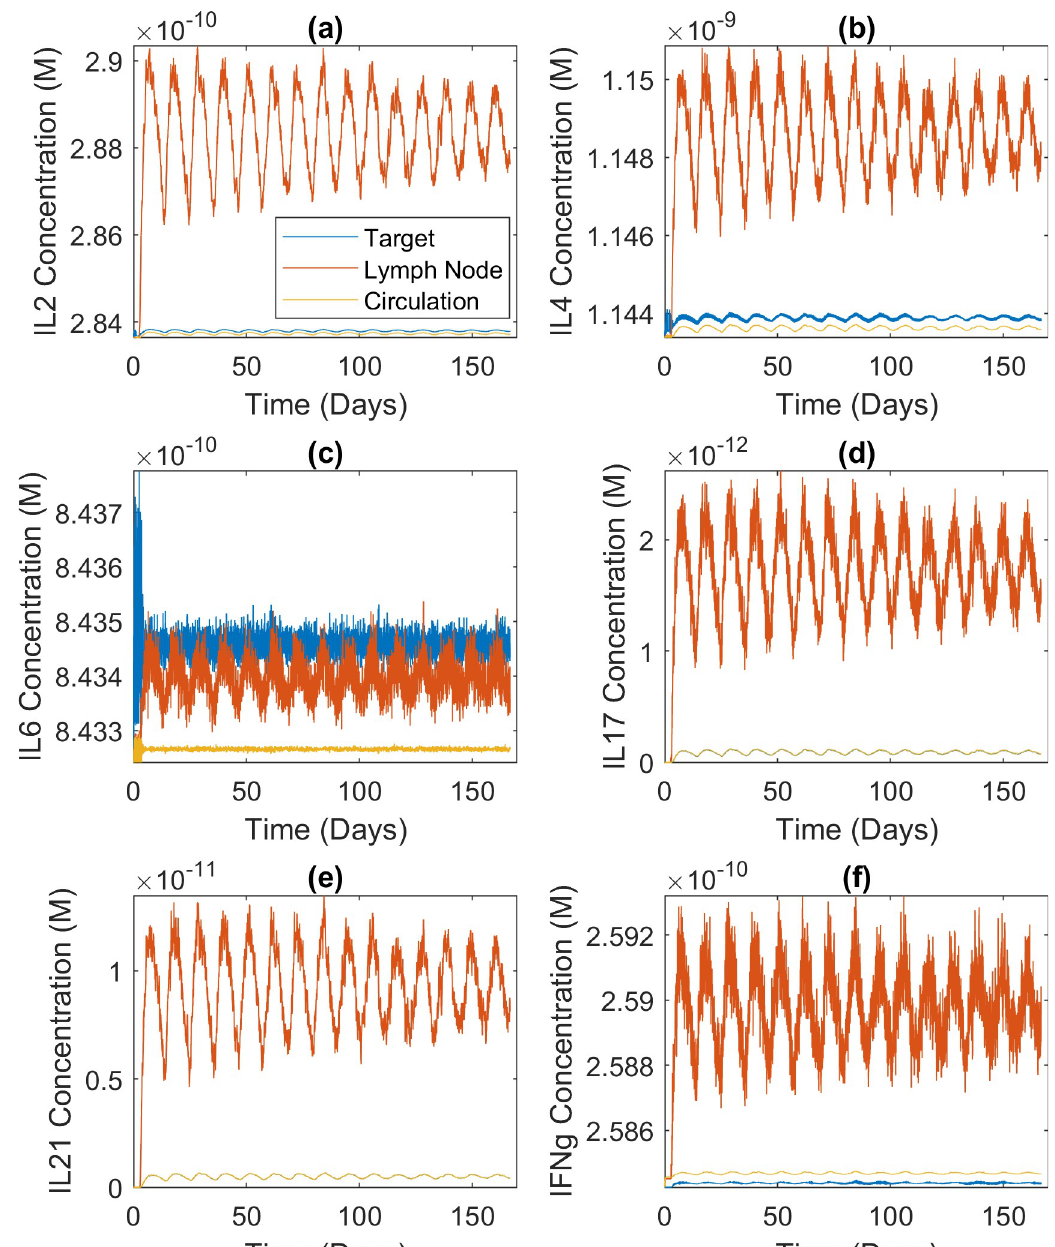
Fig 7. Cytokine concentration dynamics during chronic infection. Concentration dynamics of the six cytokines secreted by CD4+ T cells during a hypothetical chronic infection; average of 50 realizations of the modeled system. The high-frequency oscillations were caused by the stochastic nature of the problem, not numerical artifacts. Details about the signal and simulation can be found in Methods and S1 Text. (a) IL2 concentration dynamics (M). (b) IL4 concentration dynamics (M). (c) IL6 concentration dynamics (M). (d) IL17 concentration dynamics (M). (e) IL21 concentration dynamics (M). (f) IFNg concentration dynamics